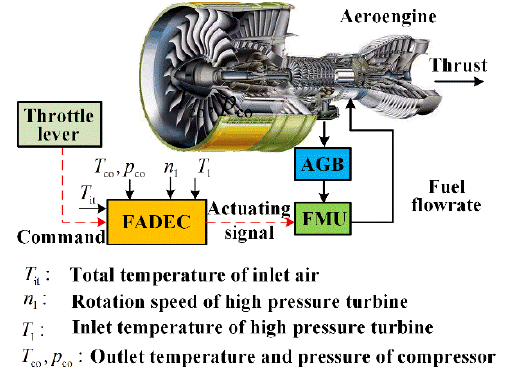
Figure 1. Typical aeroengine control system.